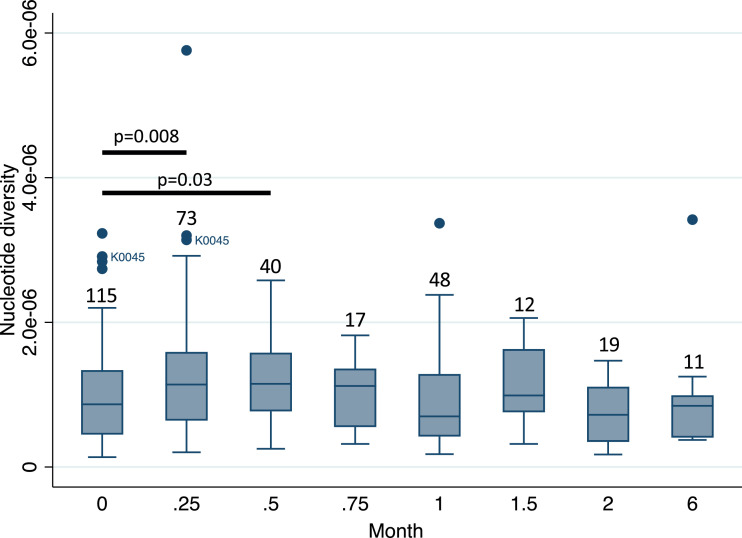
Box plot showing median and interquartile range of nucleotide diversity (π) in sequential isolates for timepoints where there were ≥5 isolates. Numbers indicate number of isolates at each timepoint. Circles mark outlying values and all represent different patients, except K0045 who was an outlier at baseline (month 0) and week 1 (month 0.25) and is labelled. Bars indicate where π statistically significantly differs from baseline (Wilcoxon rank-sum test).